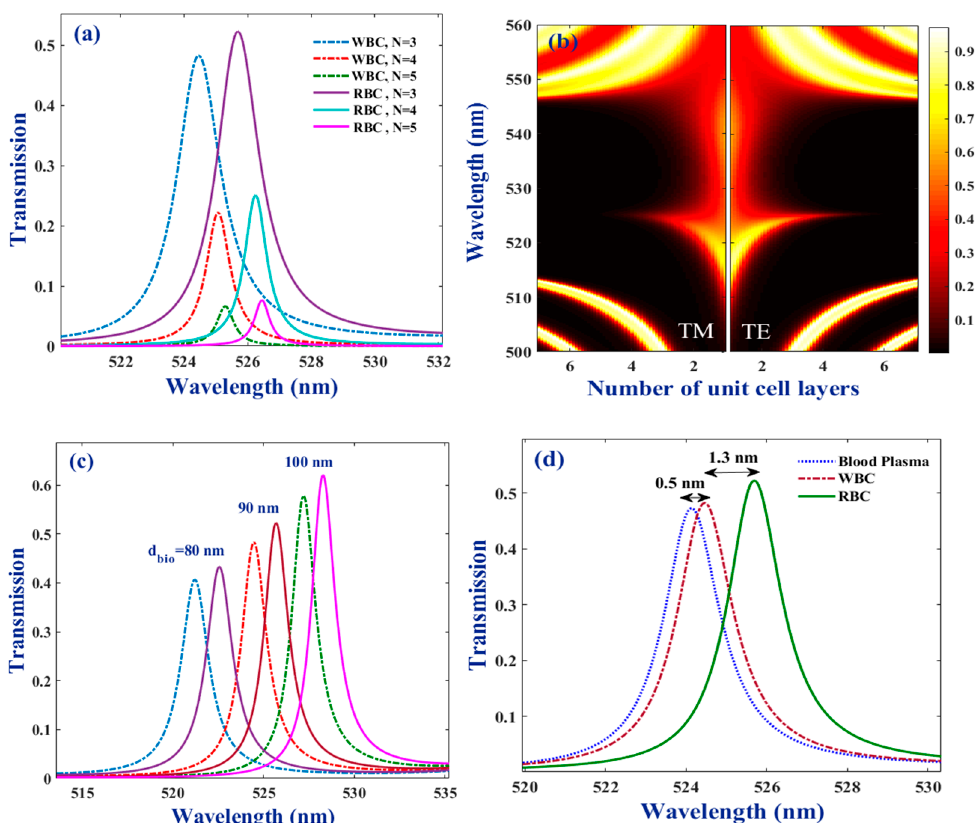
Figure 4. ( a ) Transmittance spectra for RBC and WBC samples when number of periods at each side of the bio-cell are N = 3, 4, and 5; ( b ) colormap of bio-chip transmittance versus the wavelength for the number of periods of 1 to 7 at each side of the bio-cell in the case of TE and TM polarizations; ( c ) transmittance spectra of the bio-chip for three different sizes of the bio layer—dashed lines belong to WBC sample and solid ones are for RBC; ( d ) resonant modes of WBC, RBC, and blood plasma samples—thickness of the air layer is 80 nm and other parameters are considered as presented in caption of Figure 2.